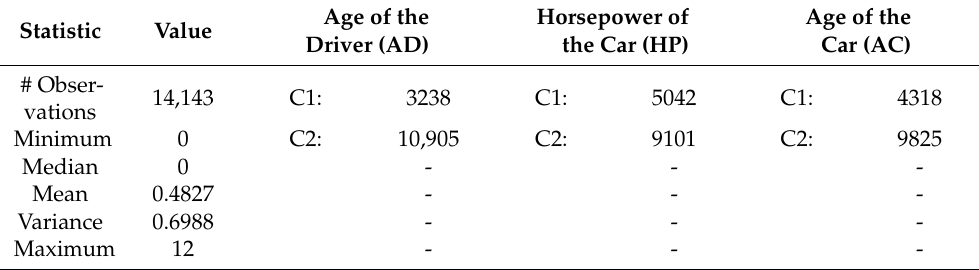
Table 1. Descriptive statistics of claim counts and the size of the different categories of the explana- tory